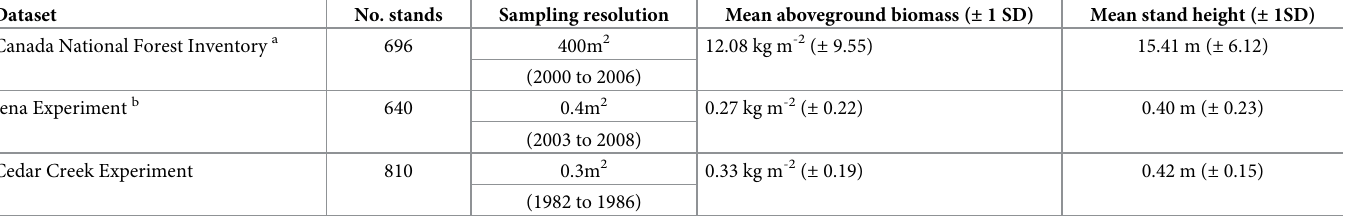
Table 1. Summary of the three datasets used to compare the biomass packing of different plant communities and their responses to external drivers. Aboveground biomass (AB) is the amount of dry standing plant tissue per unit area, while stand height (H) is the average height of canopy plants within the stand. Average photosyn- thetic height of canopy plants was used for herbaceous stands, whereas Lorey’s height was used for forest stands. Dataset No.